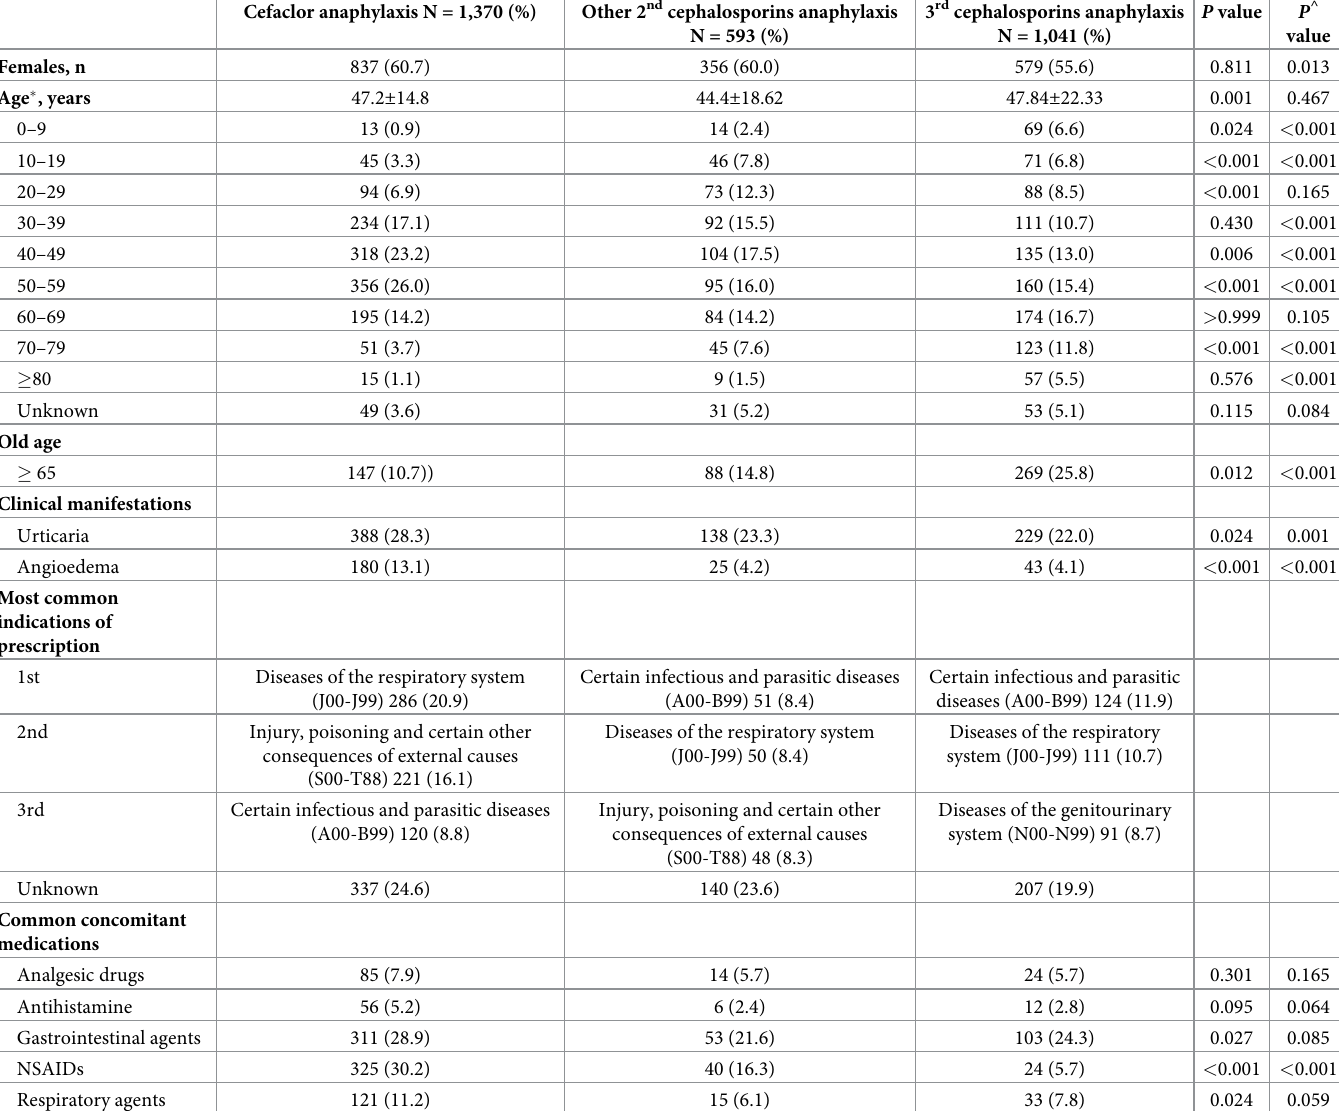
Table 5. Assessment and clinical characteristics of anaphylaxis to cefaclor and other 2 nd and 3 rd cephalosporins. Cefaclor anaphylaxis N = 1,370